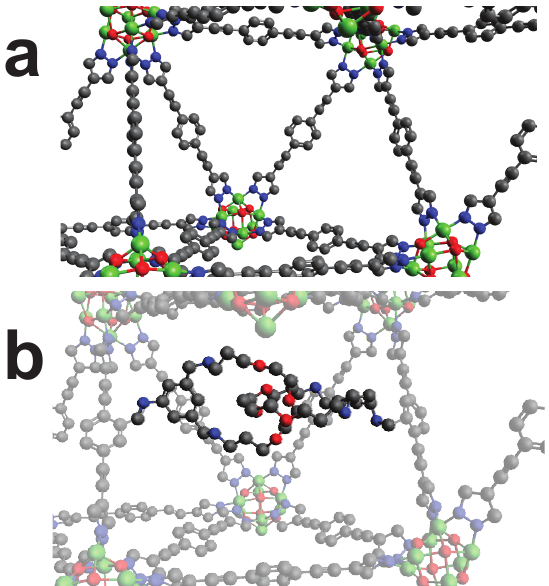
Figure 11. The MOF “BIBXOB” can be cross-linked by mechanically interlocking of two catenas. ( a ): Unmodified view of BIBXOB. ( b ): Cross-linked BIBXOB. Color code: Black (C), Blue (N), Red (O), Green (Ni). Hydrogens omitted for